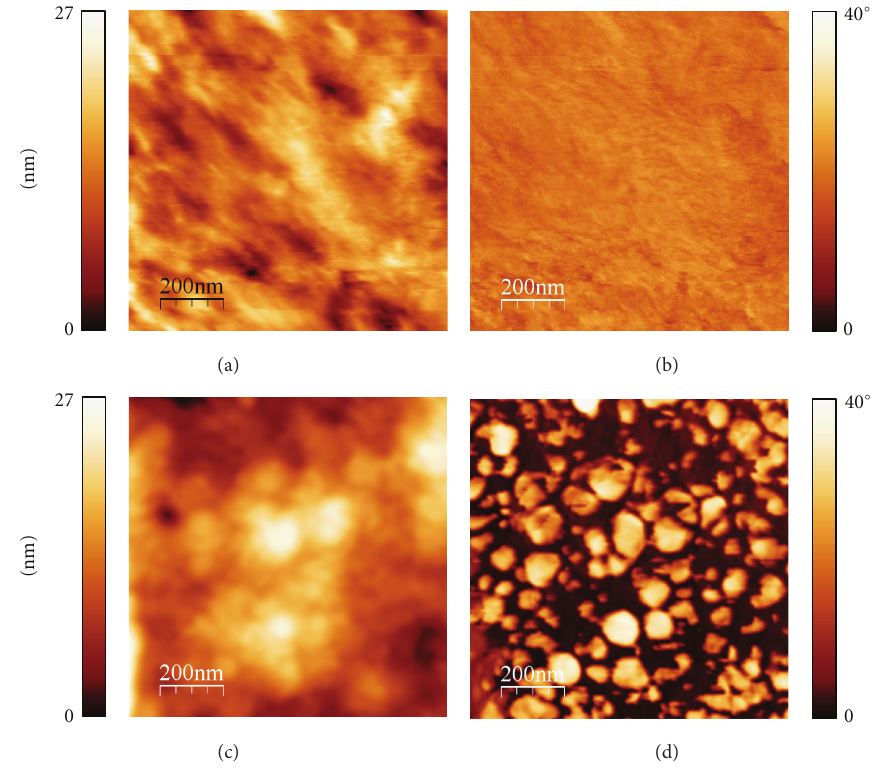
F 7: e comparison of AFM images of CAP ((a) topography, and (b) material contrast) and MCAP nanocomposite ((c) topography, and (d) material contrast).